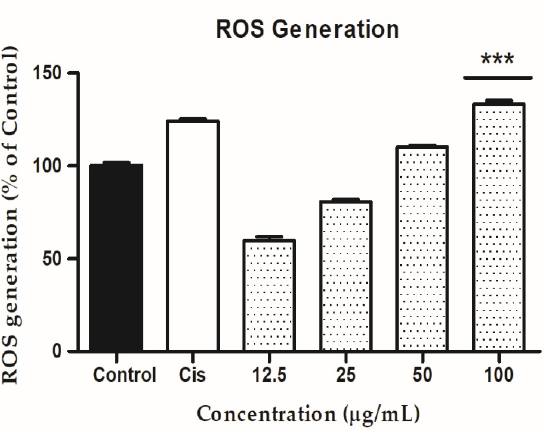
Figure 10 . In A549 cells, the ability of ginsenoside Rh1 to generate intercellular reactive oxygen spe- cies (ROS) was compared to a positive control (cisplatin). Graph shows mean ± SD values of three replicates. *** p < 0.001 indicates significant differences from control